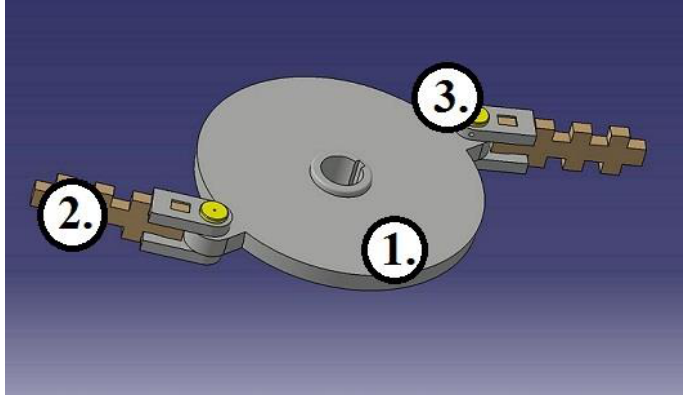
Figure 6. Innovative design of the crusher head, 1.—crusher head, 2.—crushing hammer, 3.—pin.